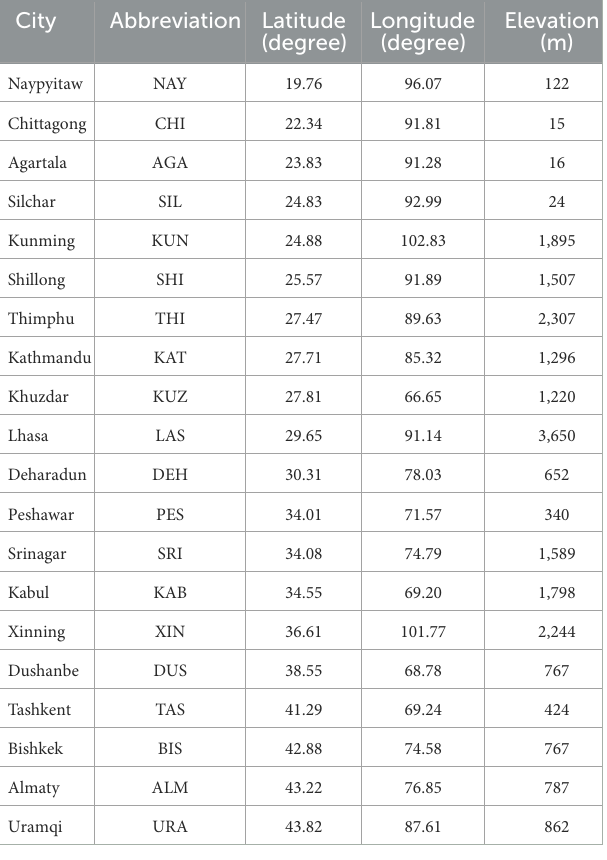
TABLE 1 The coordinates and elevation of 20 major cities in and around the study